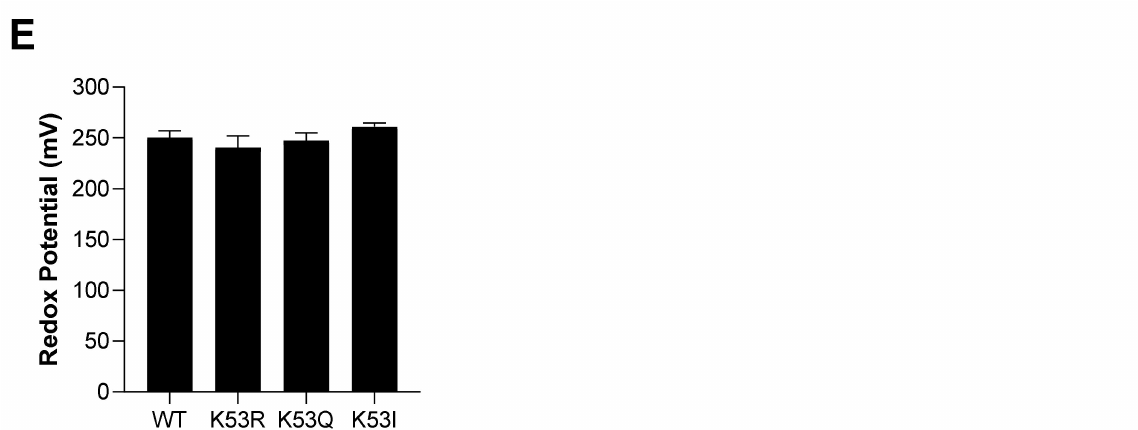
Figure 3. ( A ) Rate of oxidation of reduced Cyt c 10 s after the addition of 50 µ M H 2 O 2 ( n = 7). ( B ) Rate of reduction of oxidized Cyt c by superoxide produced in the presence of the hypoxanthine/xanthine oxidase reaction ( n = 4–8). ( C ) Heme degradation of Cyt c upon addition of excessive H 2 O 2 (3 mM) was measured as a reduction of absorbance in the 408 nm Soret peak of Cyt c ( n = 3). ( D ) Liposomes containing 0%, 20%, 30%, and 50% of tetraoleoyl-cardiolipin (TOCL) were incubated in the presence of Cyt c K53 variants. Cardiolipin peroxidase activity was determined in the presence of H 2 O 2 and Cyt c as a measure of resorufin fluorescence ( n = 5). ( E ) Redox potential of K53 variants of Cyt c were measured using the spectrophotometric method in the presence DCIP as a reference compound ( n = 5). Data are represented as means ± SEM, * p <